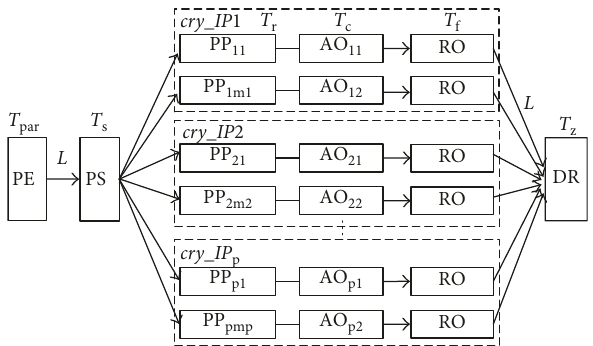
Figure 5: Dual-channel pipeline parallel data processing model